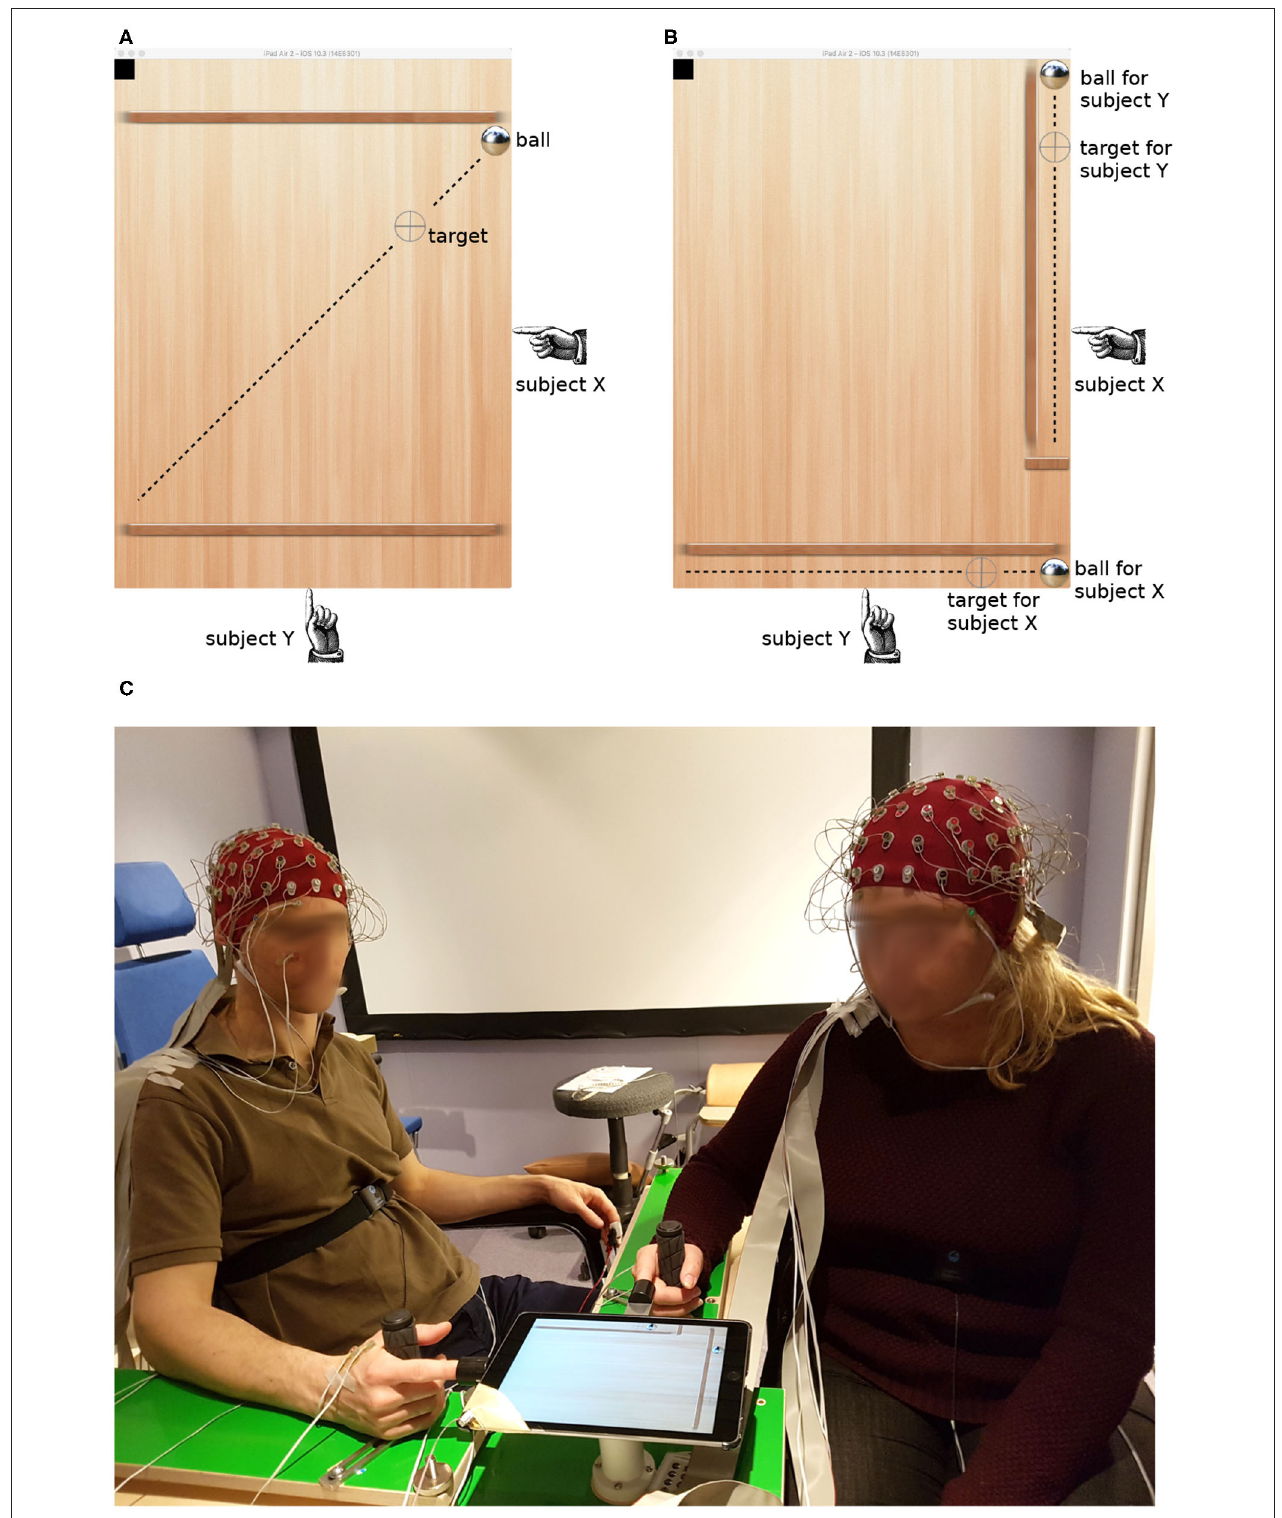
FIGURE 1 | Target tracking task in the collaborative (A) and individual condition (B) . Dashed lines visualize the trajectory of the target; they were not visible to the subjects. The picture (C) shows the experimental setup and two participants with EEG caps.